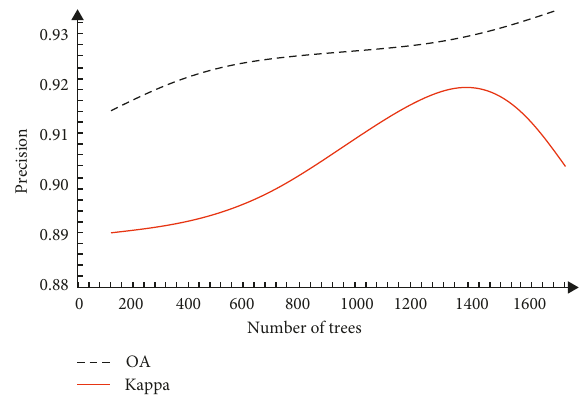
Figure 4: The relationship between the number of random forest decision trees and precision.